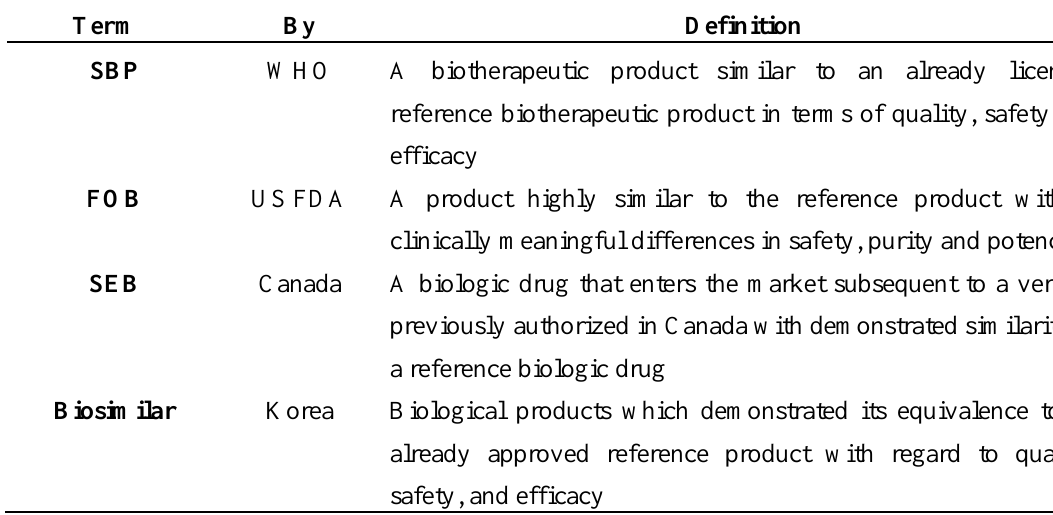
Table 1. Definitions of biosimilar